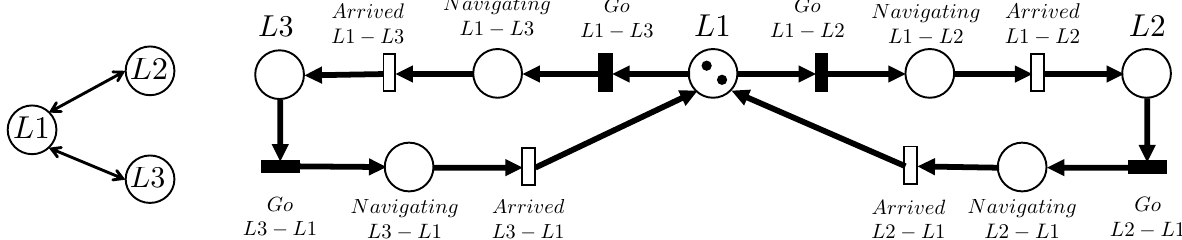
Figure 1. ( Left ) Topological map with 3 locations; ( Right ) GSPNR model of two robots navigating the topological map depicted on the